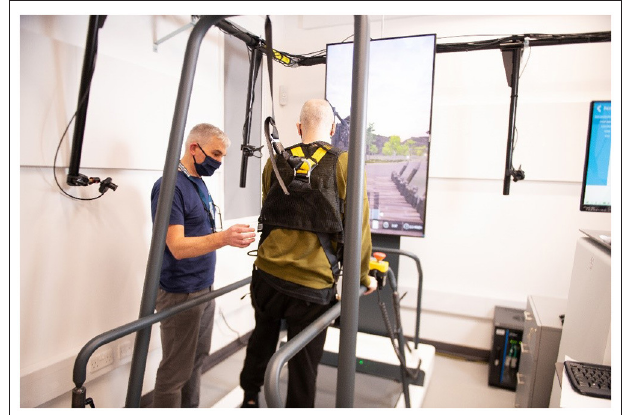
FIGURE 2 | Participant training with an interactive treadmill under